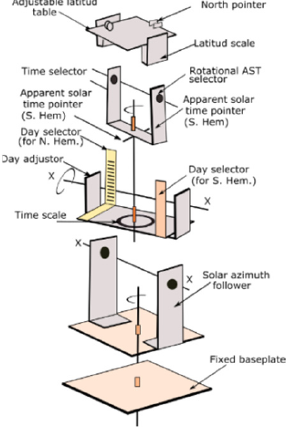
Figure 9. Heliodon with mobile light source designed by Cheung et al. in 1996.